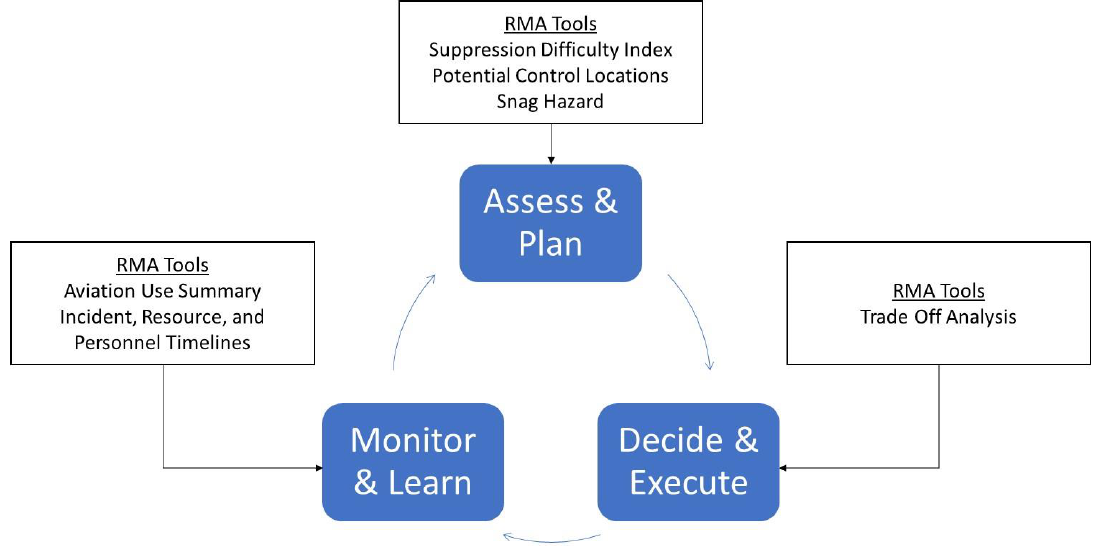
Figure 2. Stylized three-stage risk management decision cycle and its relationship to highlighted RMA tools; adapted from Thompson et al. [34].